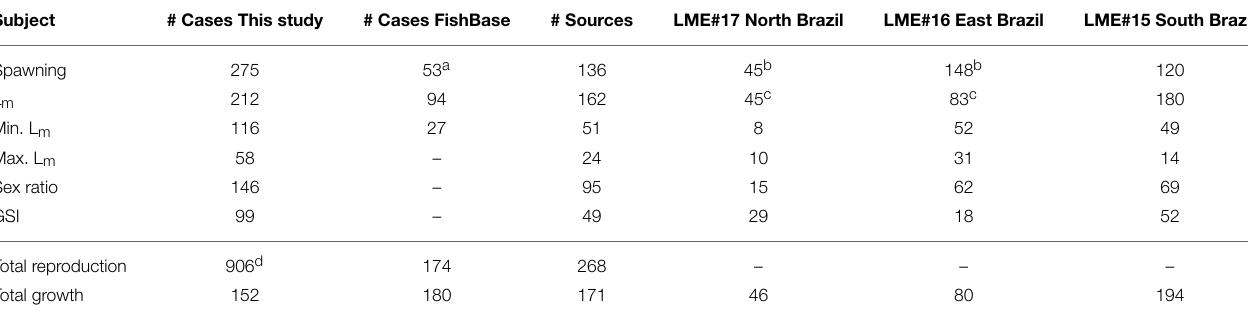
TABLE 1 | Total number of cases on reproduction and growth compiled in this study and from FishBase: spawning months, length at first maturity (L m ), minimum and maximum length at first maturity as defined in Froese and Pauly (2000), sex ratio (F:M), gonadosomatic index (GSI), and growth parameters (L ∞ , K, and t o